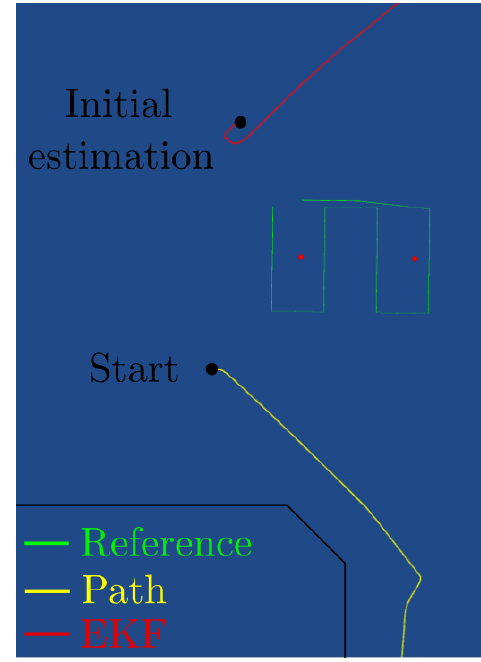
Figure 8. Scenario 2 with extended Kalman filter.